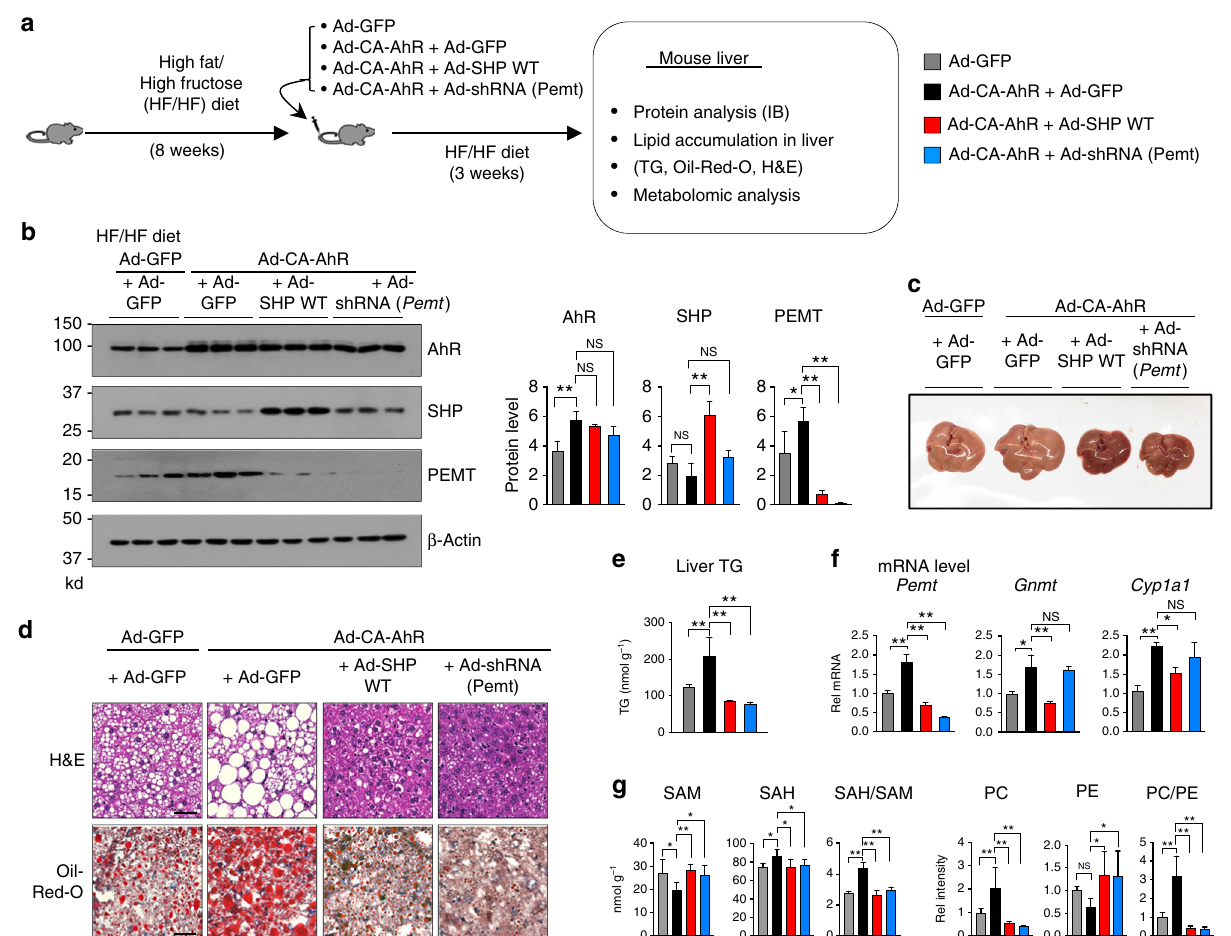
Fig. 7 Downregulation of Pemt or overexpression of SHP blunts AhR-mediated increases in PC levels and liver steatosis in mice fed HF/HF. a Experimental outline: Mice ( n = 5 mice per group) were fed a HF/HF diet for 8 weeks and infected with the indicated adenovirus. For the Ad-CA-AhR injection, Ad-GFP was added so that the same number of viral particles were injected for each group. At 3 weeks after adenoviral injection, livers were collected for further analyses. b Samples from three mice per each group were randomly selected and analyzed by IB (left) and quanti fi cation of the bands is shown (right). Full size immunoblots are in Supplementary Figure 12d. c Representative images of livers from the experimental groups. d Oil Red-O staining of frozen liver sections. Scale bar: 100 µ M. e Liver TG levels. f mRNA levels of Pemt, Gnmt, and Cyp1a1 as determined by qRT-PCR. g Ratios of SAH/SAM and PC/PE as calculated from levels of these metabolites determined by LC – MS ( n = 5). Means ± SD are shown ( n = 5 mice), and statistical signi fi cance was measured using the b - (right), e – g one-way ANOVA with the FDR post-test. * P < 0.05, ** P < 0.01, NS, not statistically signi fi